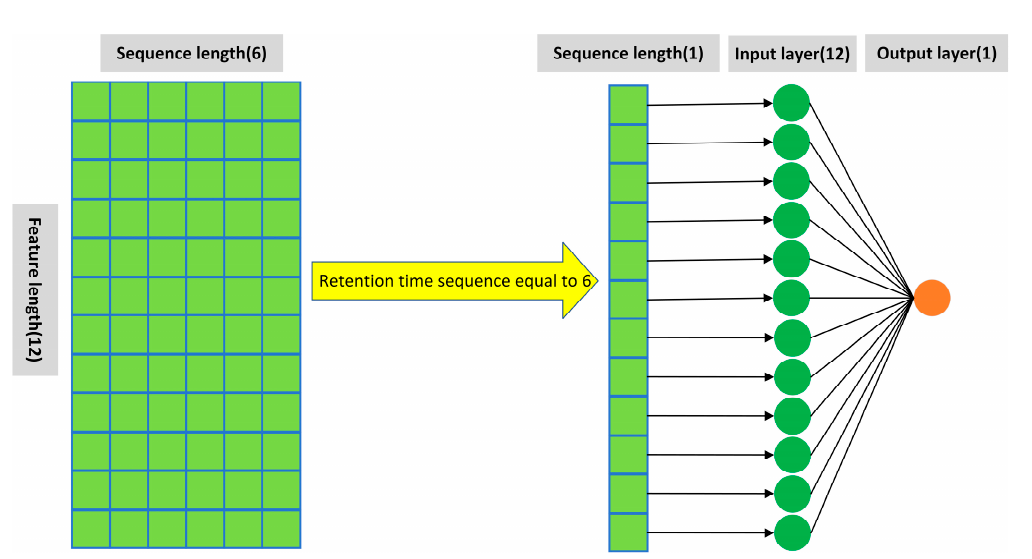
Figure 12. Feature_Reconfiguration. Figure 12.